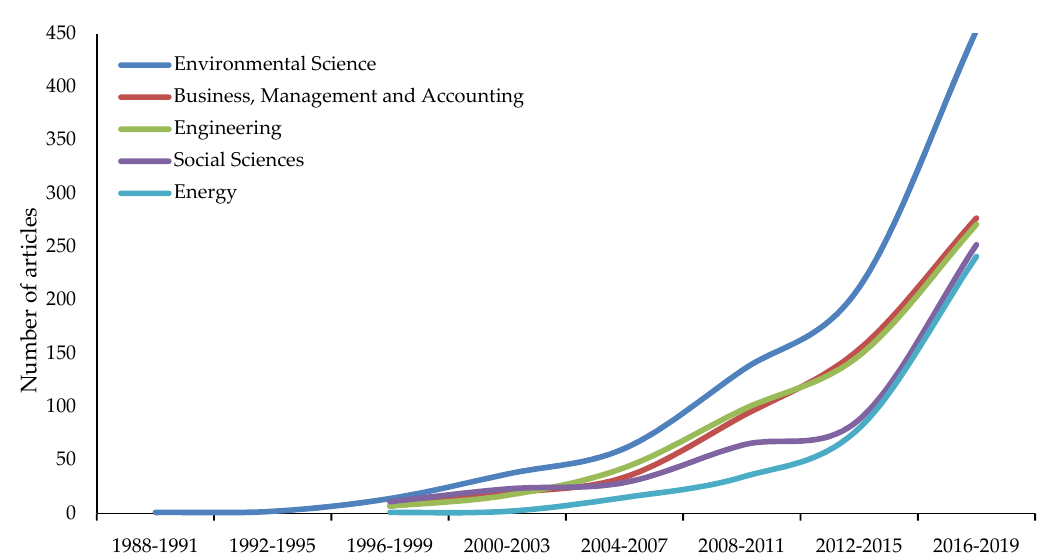
Figure 3. Comparison of growth trends of main subject areas (1988–2019).